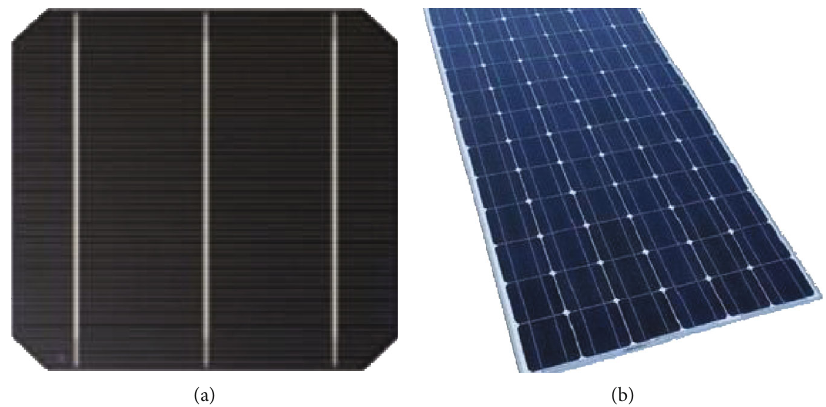
Figure 7: Monocrystalline (a) and multicrystalline (b) solar cells [45, 60].